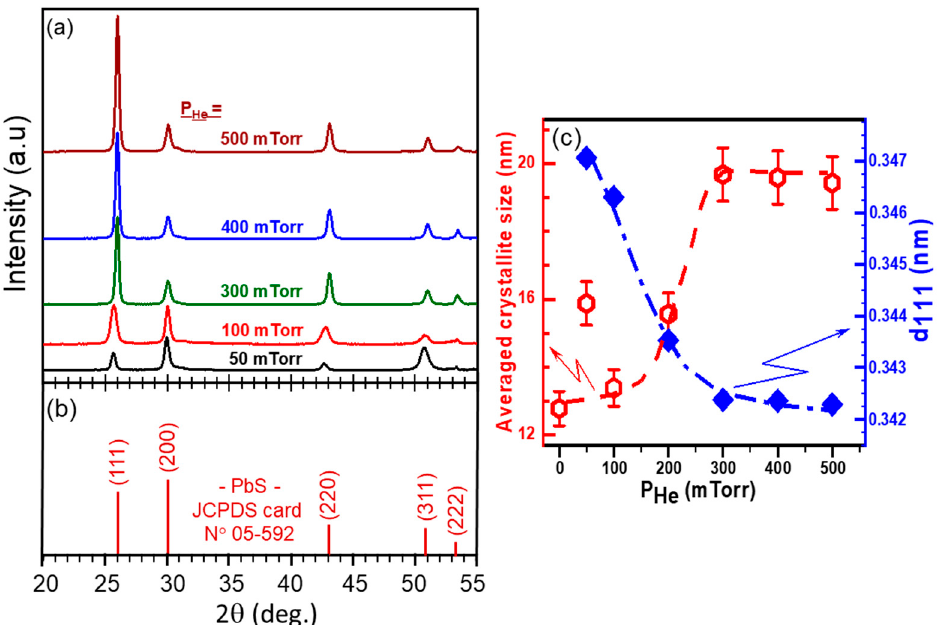
Figure 3. ( a ) XRD patterns of PbS films deposited at different He pressures ranging from 50 to 500 mTorr (at N LP = 3500); ( b ) Standard XRD peak positions and intensities for PbS powder according to the JCPDS card N ◦ 5-592); and ( c ) He pressure dependence of both the crystallite size and lattice parameter of the (111) plans (d111).